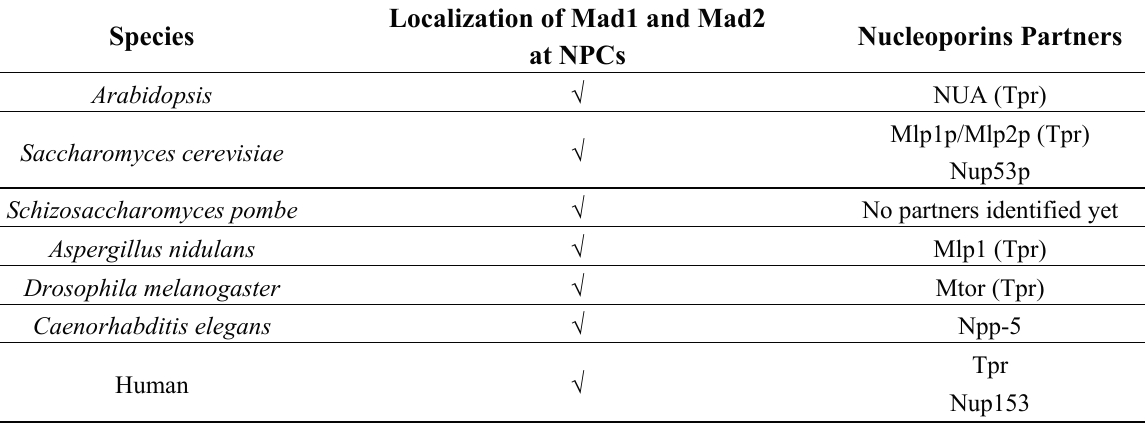
Table 1. Summary of known Mad1- and Mad2-interacting nucleoporins in distinct species. Species